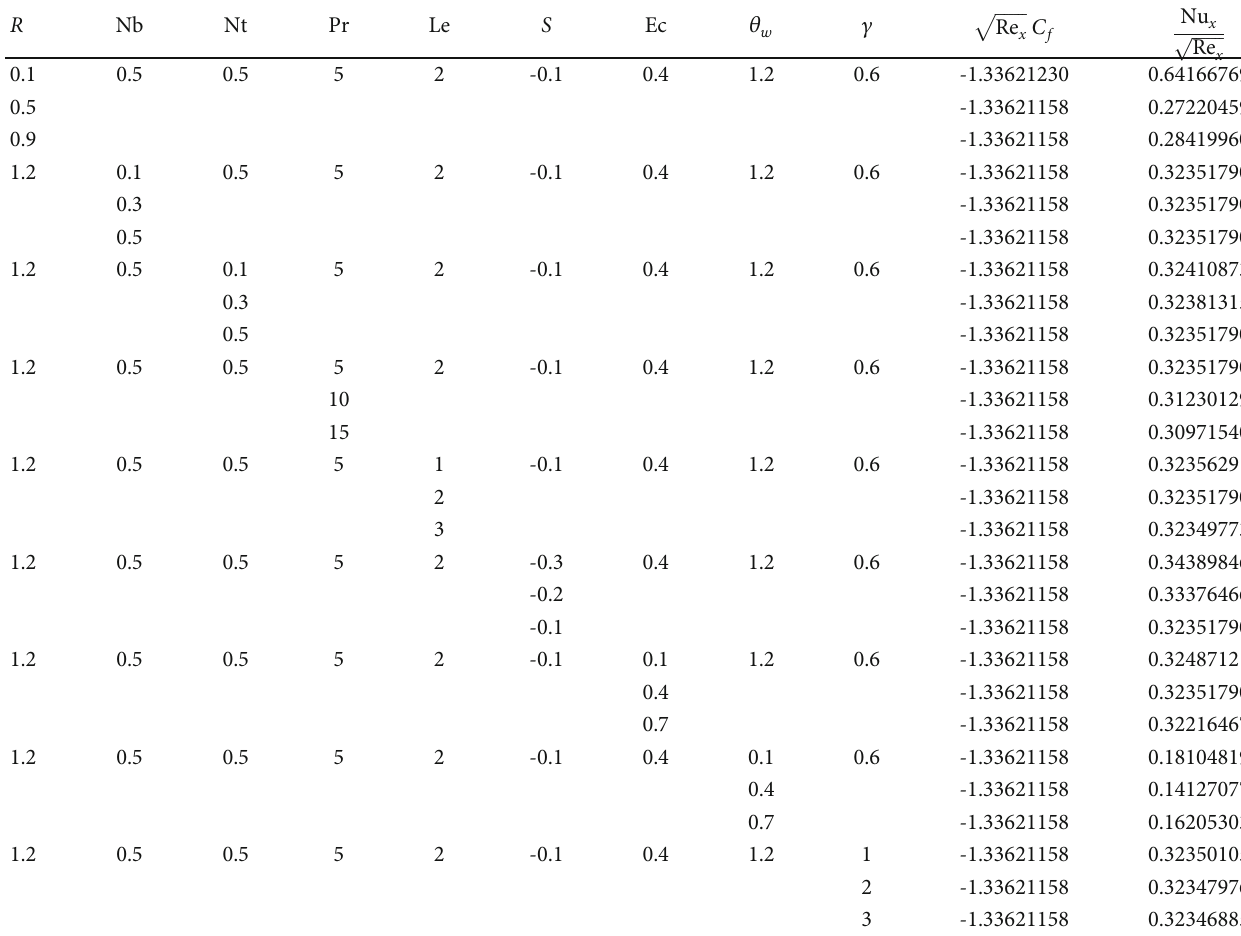
ffiffiffiffiffiffiffi p Nu / Re for all values of x x